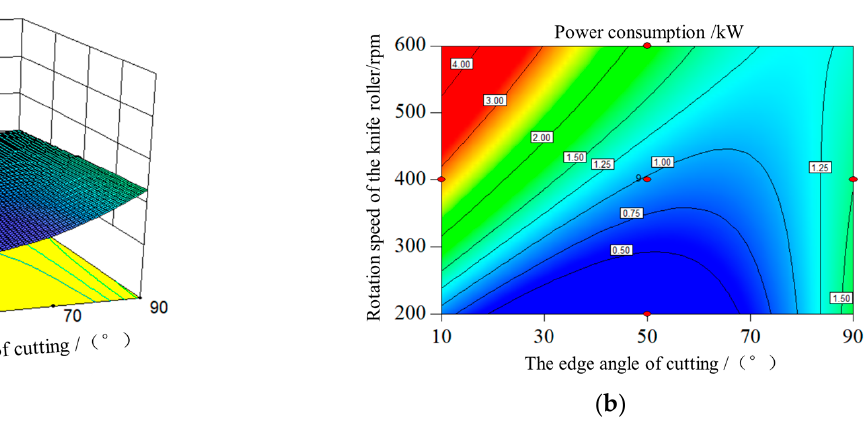
Figure 9. In fl uence law of each factor on power consumption. ( a ) Response surface diagram. ( b ) Contour diagram. ( b ) Contour